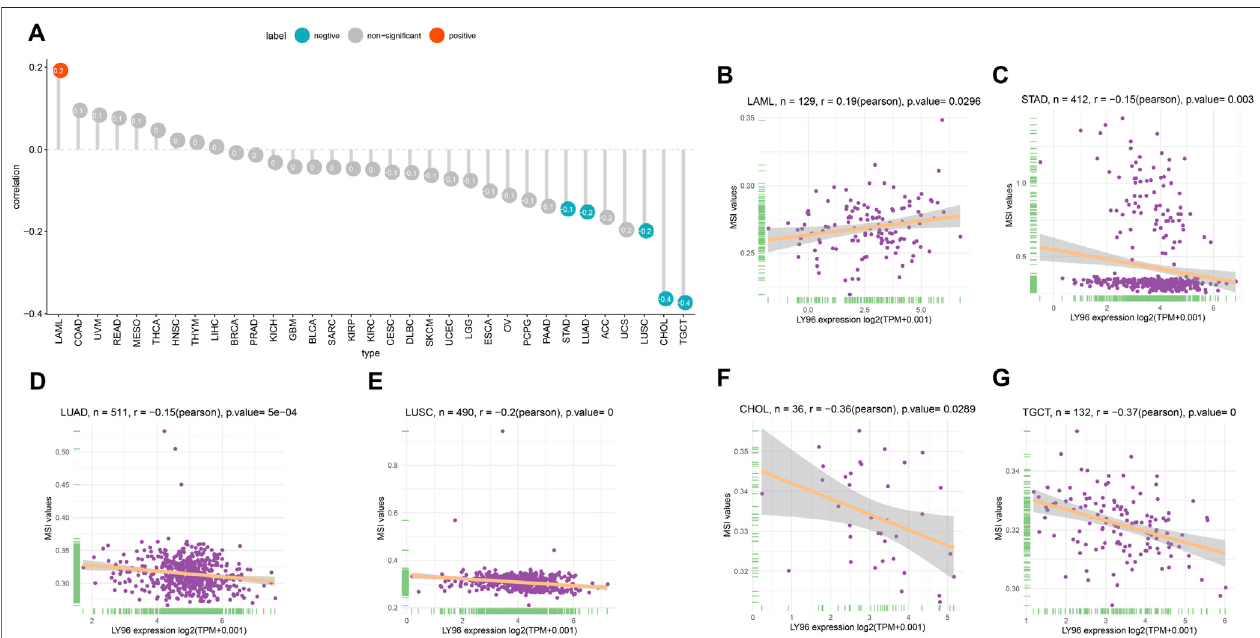
FIGURE 8 | Correlation between LY96 expression and MSI. (A) Correlation between LY96 expression and MSI across cancers. (B – G) Correlation between LY96 expression and MSI in (B) acute myeloid leukemia (LAML), (C) stomach adenocarcinoma (STAD), (D) lung adenocarcinoma (LUAD), (E) lung squamous cell carcinoma (LUSC), (F) cholangiocarcinoma (CHOL), and (G) testicular germ cell tumors (TGCT).